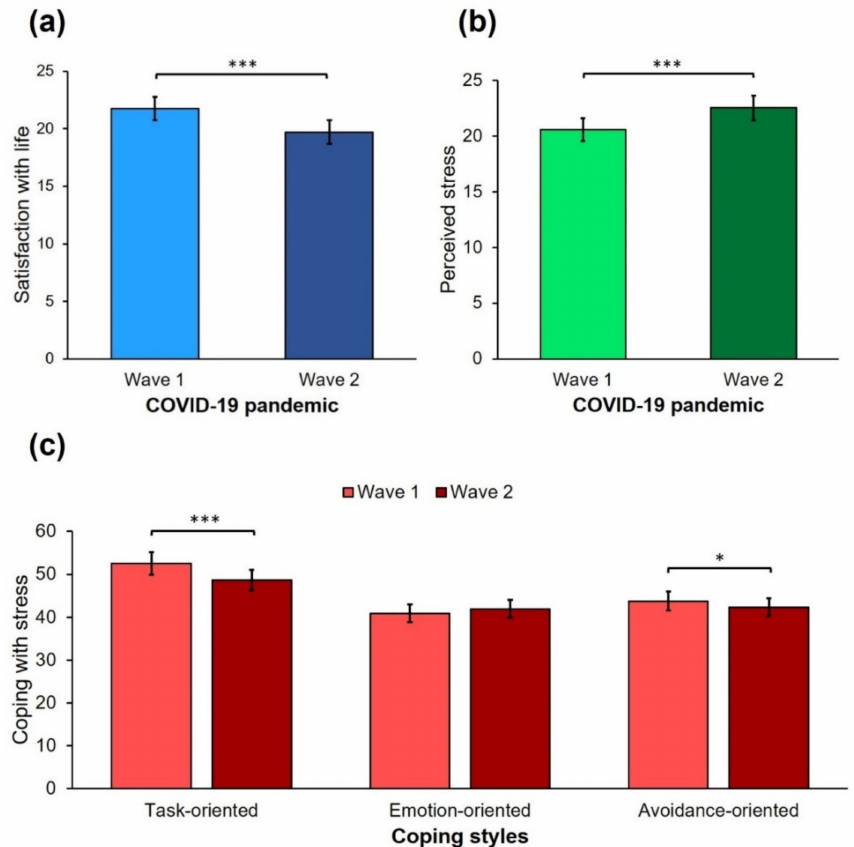
Figure 2. Differences between the first and second waves of the COVID-19 pandemic in ( a ) satisfaction with life; ( b ) perceived stress; and ( c ) task-oriented, emotion-oriented, and avoidance-oriented coping styles. * p < 0.05, *** p < 0.001.